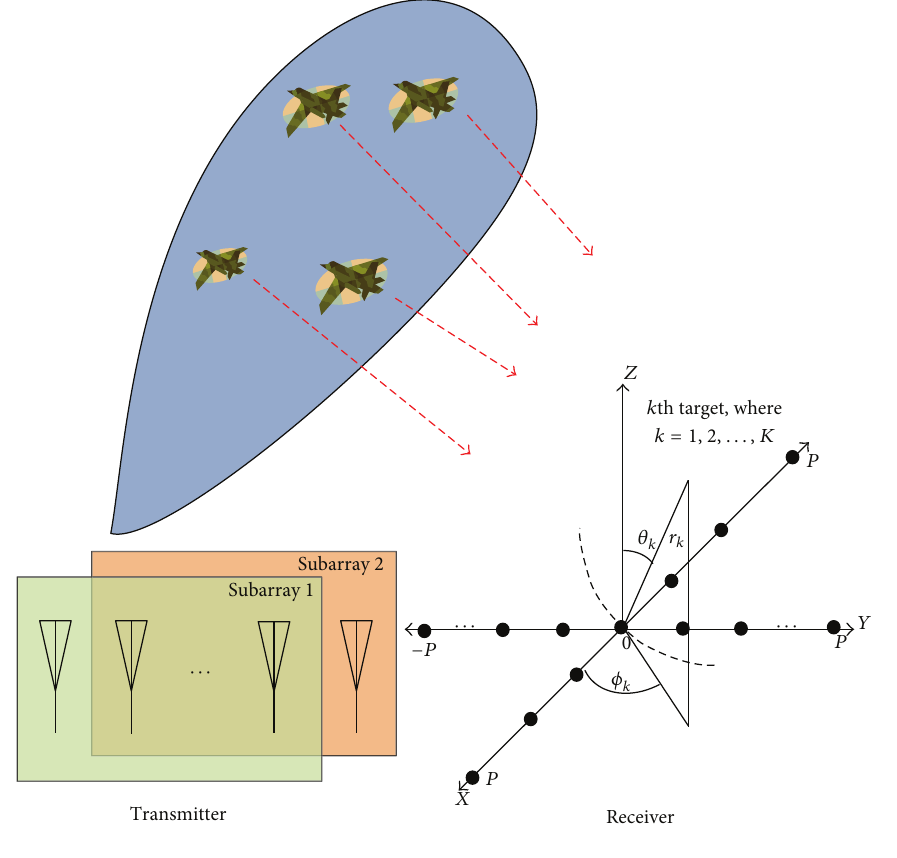
Figure 1: Schematic diagram for Bistatic